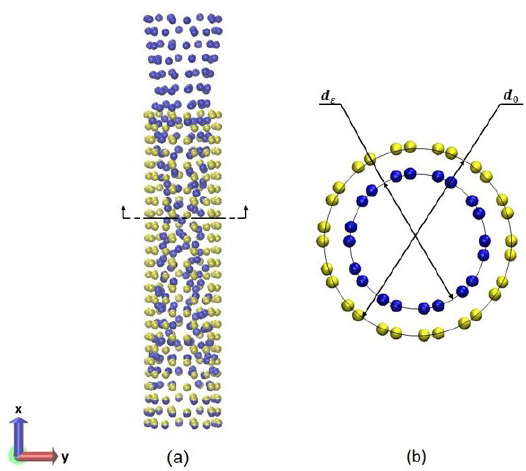
Figure 9. (a) schematic view of a SWSiNT in equilibrium state (Yellow atoms) and Strained state (blue atoms) (b) Middle Cross section view, d_((ε)) and d_0 denote diameter of nanotube in strained state and initial state respectively.